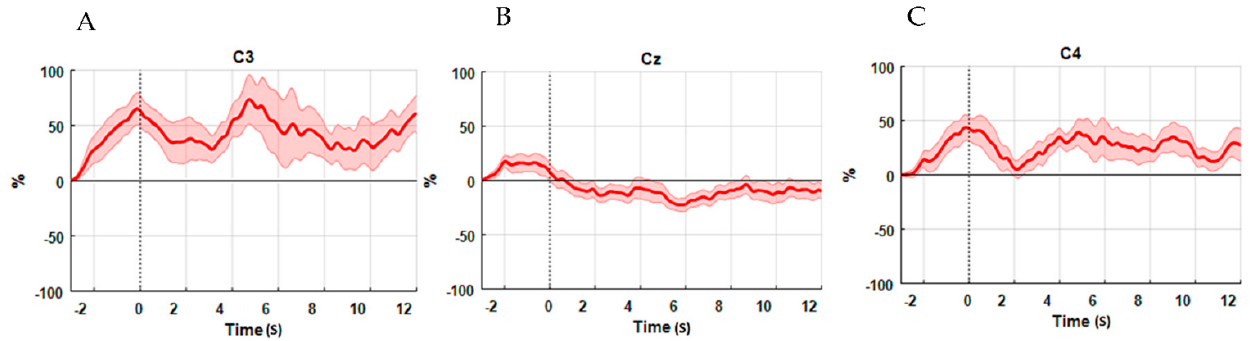
Figure 9. Time course of the ERD/ERS transitions for right ankle joint movements. The EEG signals power of ( A ) C3, ( B ) Cz, and ( C ) C4.